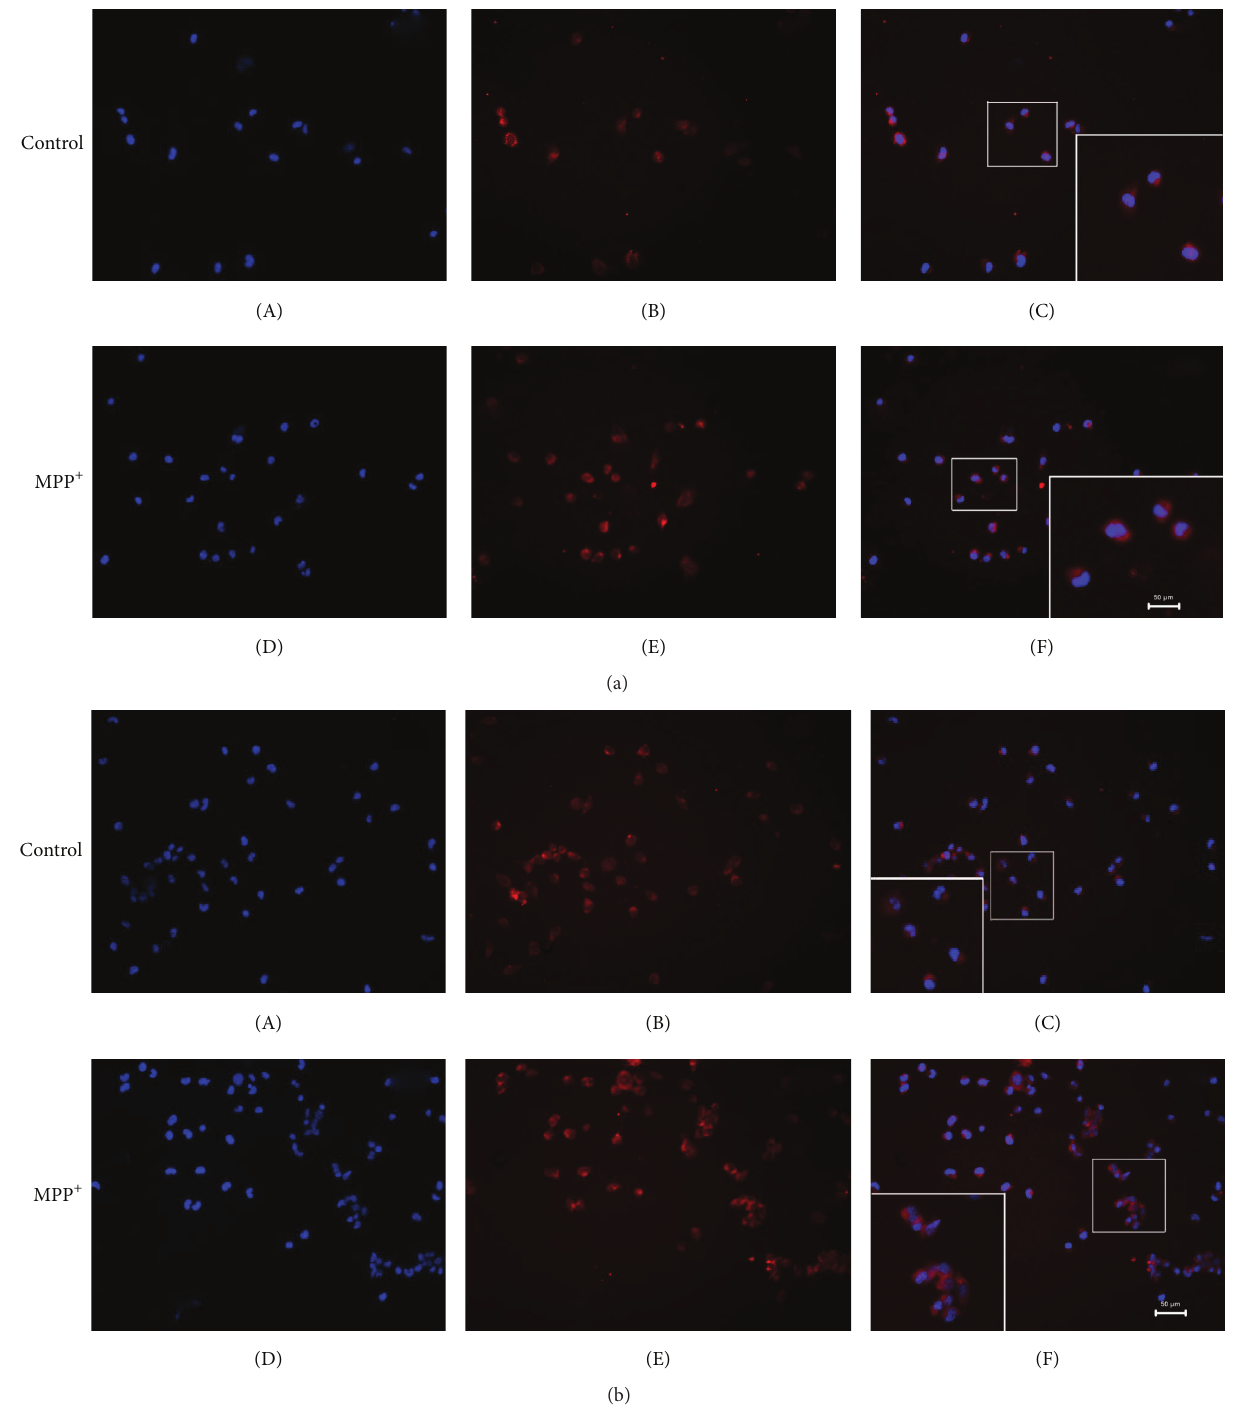
Figure 7: The expression of TLR2/TLR4 in BV-2 cells exposed to MPP + for 12 h (fluorescent microscope image, 200x). Note that MPP +